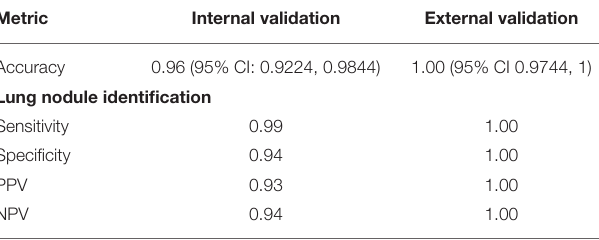
TABLE 3 | Performance metrics for identification of lung nodules.